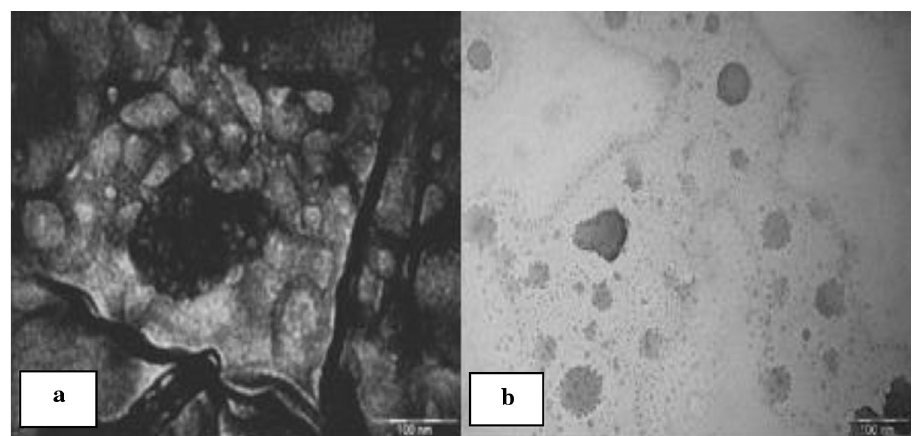
Figure 5. ( a ) Transmission Electron Microscopy image of annealed cadmium oxide nanoparticles showing spherical shapes, ( b ) unannealed nanoparticles showing non-uniform